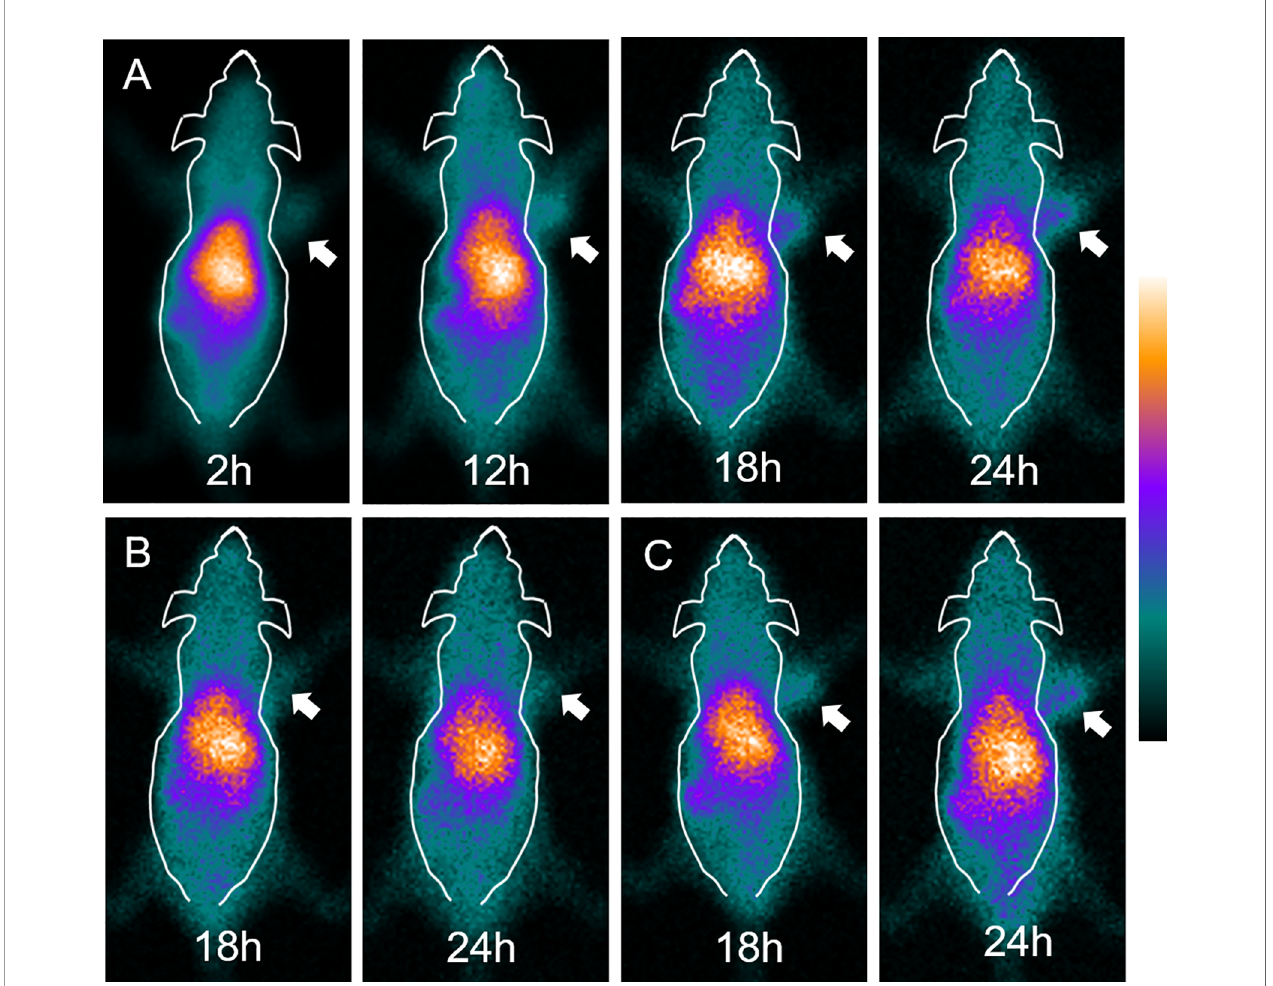
FIGURE 2 | SPECT imaging of tumor-bearing nude mice injected with 99m Tc-HYNIC-S1PR1mAb. (A) SPECT imaging of SK-HEP-1 tumor-bearing nude mice at 2 h, 12 h, 18 h and 24 h. (B) SPECT imaging of blocked SK-HEP-1 tumor-bearing nude mice at 18 h and 24 h. (C) SPECT imaging of MCF-7 tumor-bearing nude mice at 18 h and 24 h The white arrows indicate the tumor